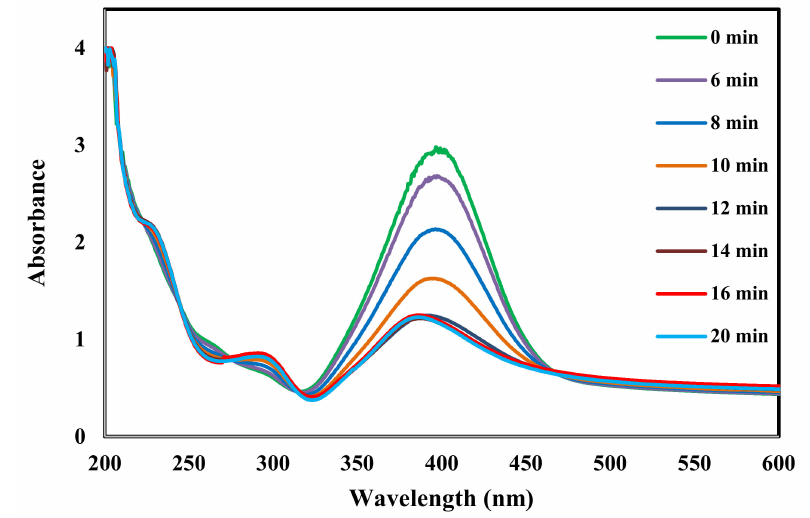
Figure 9. Time-dependent UV-vis spectra for monitoring 4-nitrophenol reduction by catalyzed by AgNPs under the conditions of 20 mL of 50 ppm 4-nitrophenol, 2 mL of H 2 O 2 , 0.3 g of Catalyst, 25 ◦ C, 250 rpm for 20